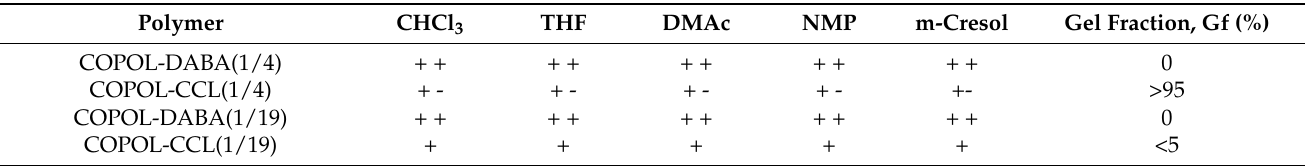
Table 3. Solubility of copolyimides and gel fraction.